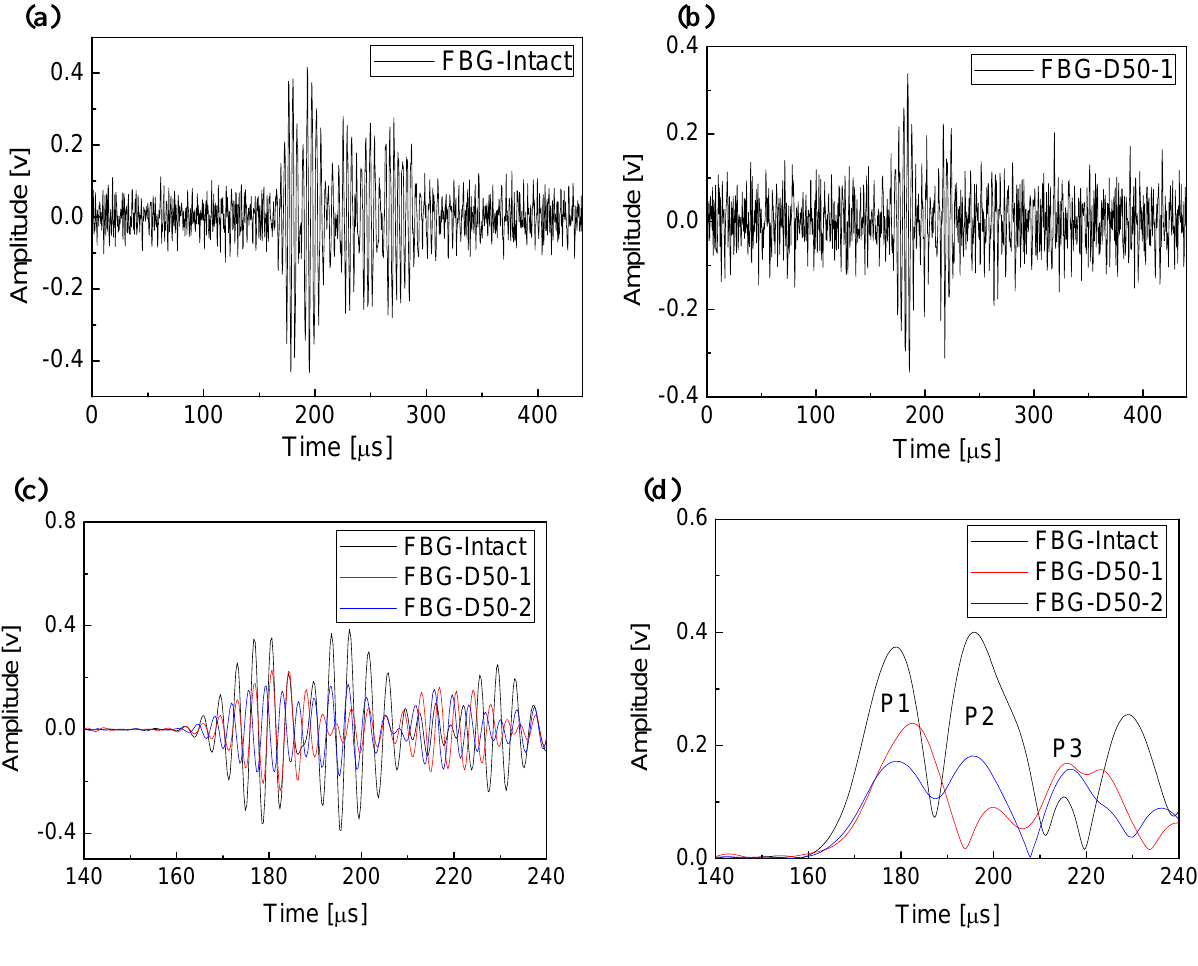
Figure 6. FBG-based results. Guided wave signals of the intact (a) and the single- delaminated (b) CFRP laminates. Waveforms (c) of filtered guided wave signals of the intact and the damaged CFRP laminates and their envelopes